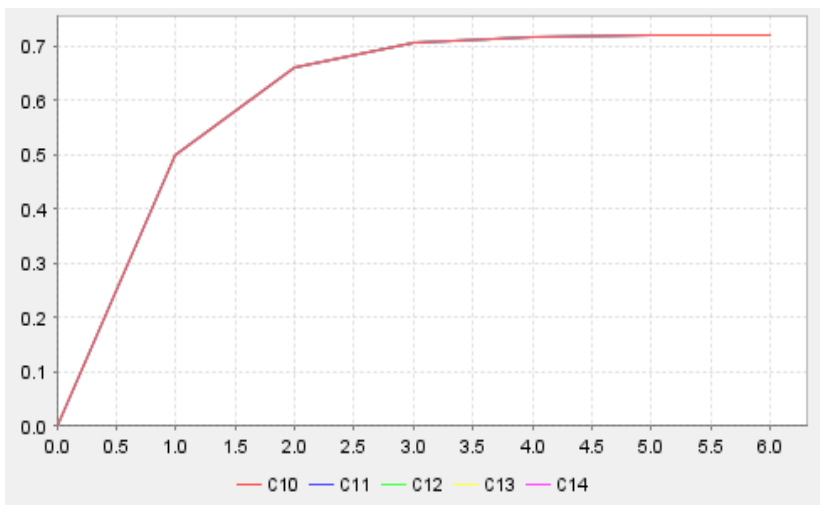
Fig. 14. FCM of E & H inference